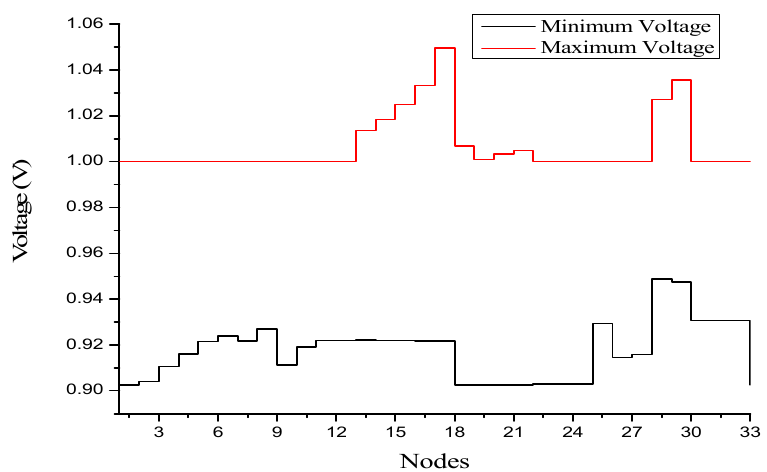
Figure 2. Minimum and Maximum voltage at each node after integrating RES and EVCS.